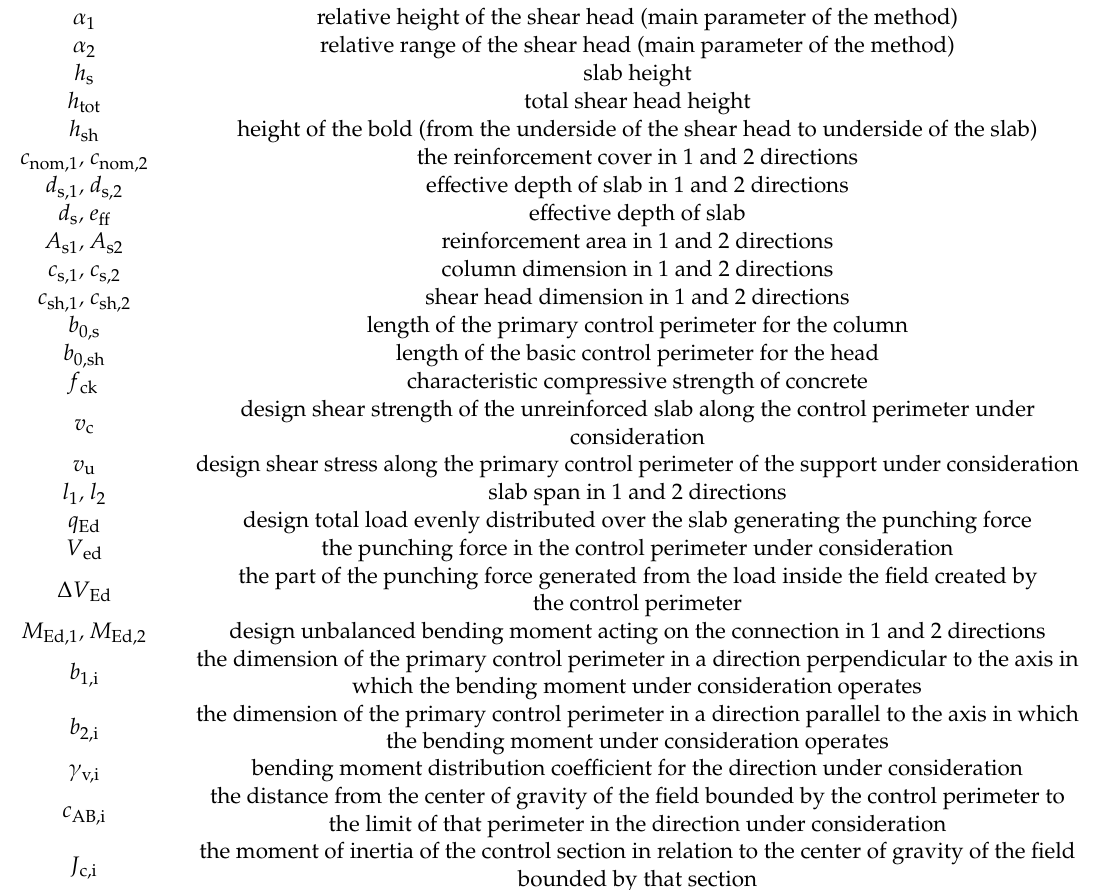
Table A2. Notations used in Appendix